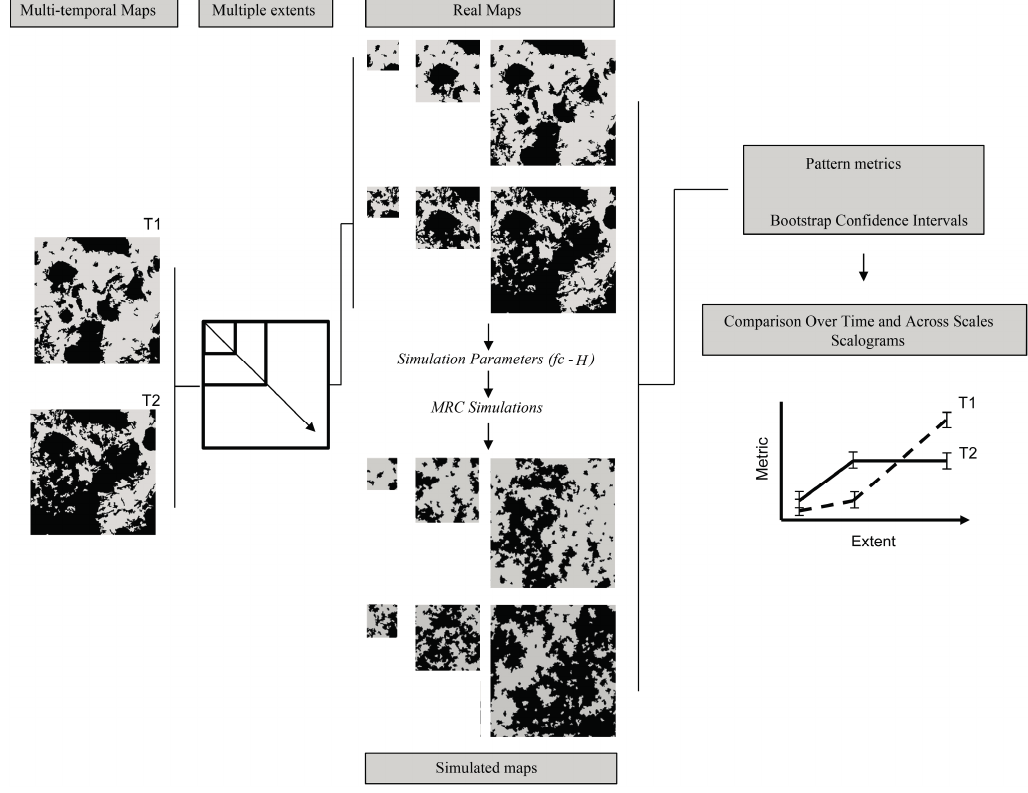
Figure 2. Flowchart representing the different steps of the proposed procedure for detecting significant changes in forest spatial pattern at different scales. T1: 1954; T2: